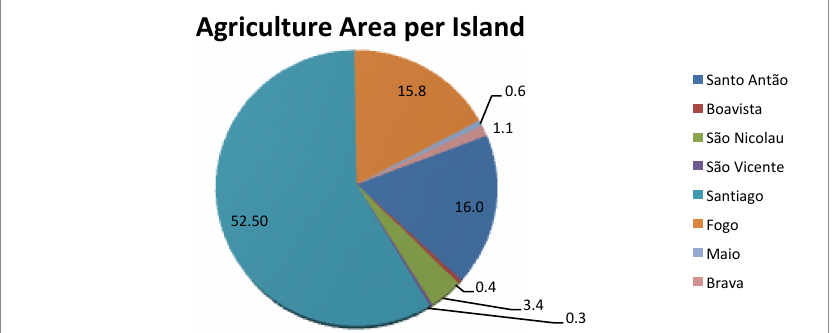
Figure 1. Agriculture area per inhabited island of Cabo Verde archipelago (in percentage). Data not represented for Sal Island, with only 0.01% of agriculture area.